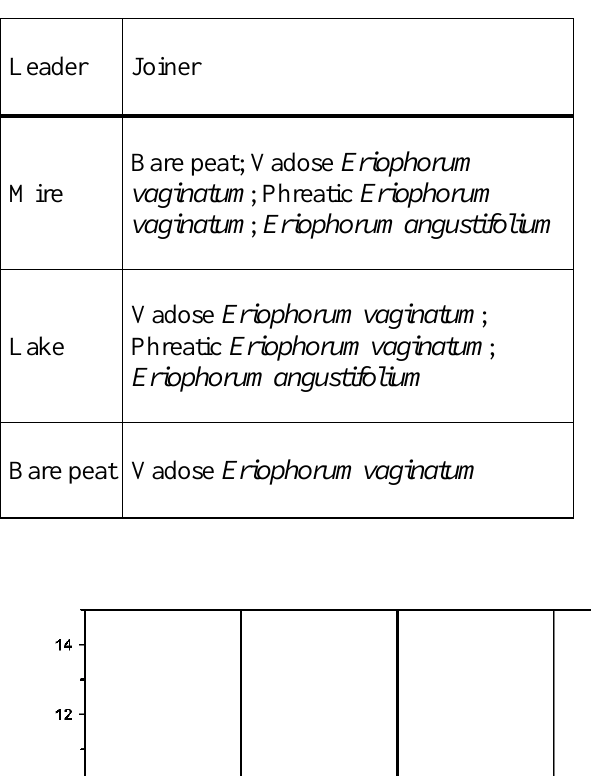
Table 7. Ecotope pairs with significantly different CO 2 fluxes to the atmosphere ( P ≤ 0.05) based on the linear mixed effects model. (Pairwise comparisons among least-squares means; results were averaged over the levels of soil water condition; P value adjustment: Tukey method for comparing a family of seven estimates).